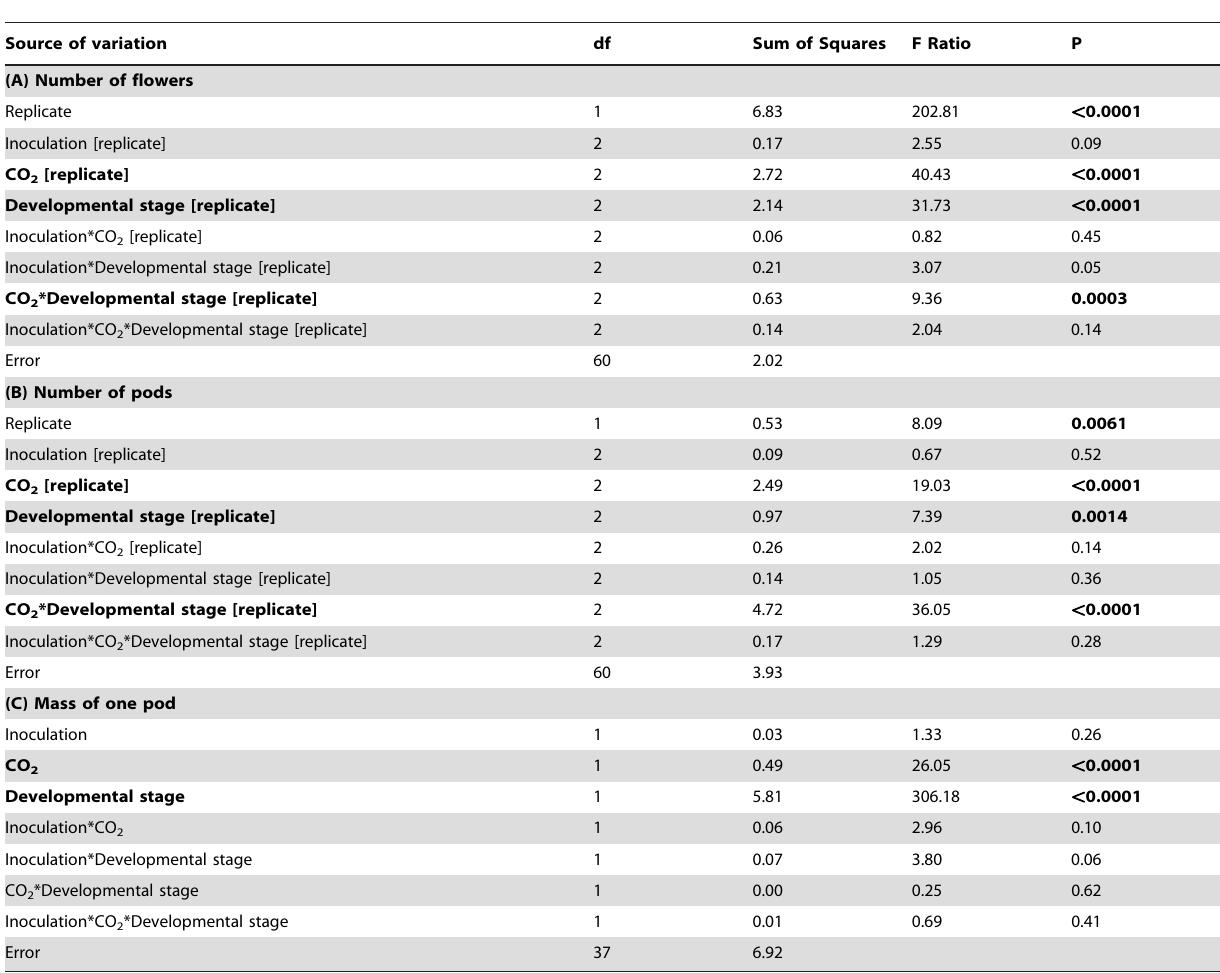
Table 3. Linear models explaining the reproductive traits of Medicago truncatula as a function of inoculation conditions (inoculated or not with Pseudomonas fluorescens C7R12), CO 2 concentration (ambient, 365 ppm or enriched, 750 ppm) and the plant developmental stage (Fp and Pf, see text), excepting for the pod mass (C) which was measured in the second experimental replicate